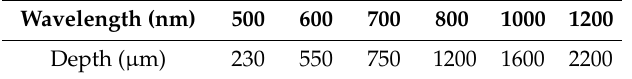
Table 2. Approximate penetration depth of optical radiation in skin tissue [13].